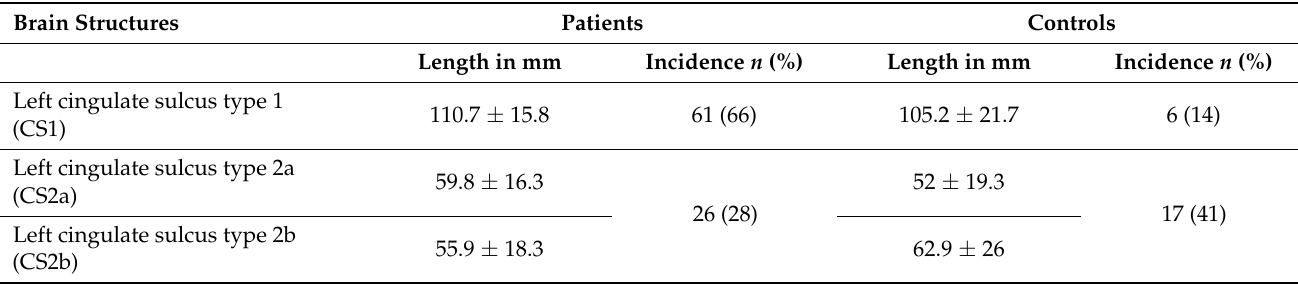
Table 3. Detailed analysis of the length of the parcellated CS and PCS on the left and right side in schizophrenia patients and controls and their incidences. The data are presented for all types of morphology (CS types 1, 2, 3 and PCS types 0, 1, 2). The length data are presented as mean values in mm ± SD. The incidence is presented as a number of cases ( n ) and their percentages. Incidences of CS types 2 and 3 are given as a single value for all relevant sulcal parts (segments). Statistical significance was calculated by nonparametric Mann–Whitney U test and Kruskal–Wallis test ( p <